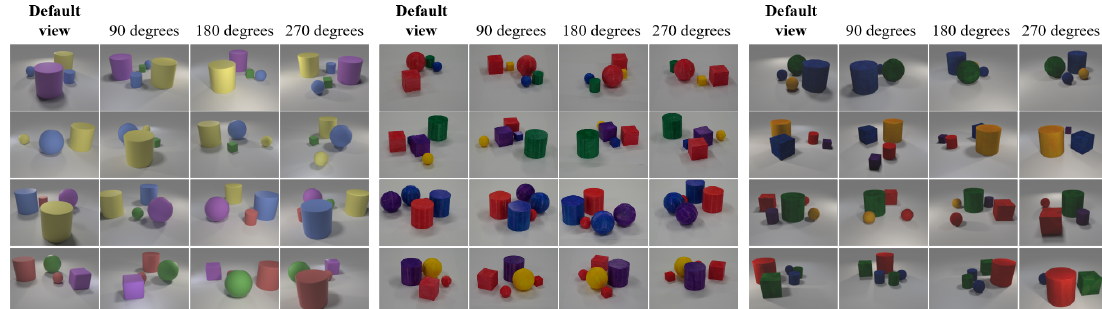
Figure 6. Example images from Multi-view-CLEVR_4views_ CG ( left ) which is entirely built from simulated scenes, Multi-view-CLEVR_4views_ Real ( middle ), which are created from photographing real table scenes composed of real object models, and a Multi-view-CLEVR_4views_ 3DMFP ( right ) dataset that is built from importing scanned real object models into simulated scenes and aimed for fine-tuning.